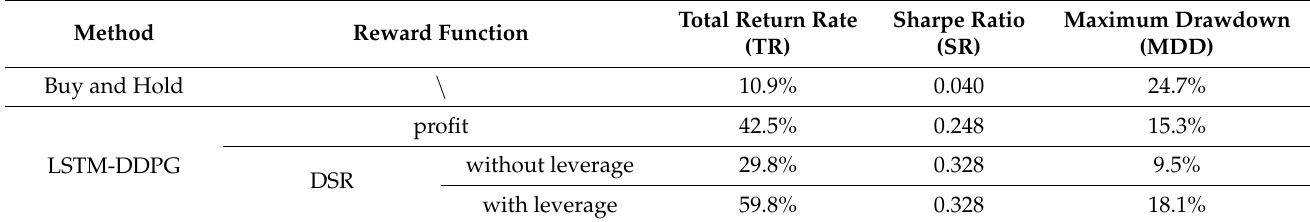
Table 2. Performance of buy and hold, LSTM-DDPG with different reward